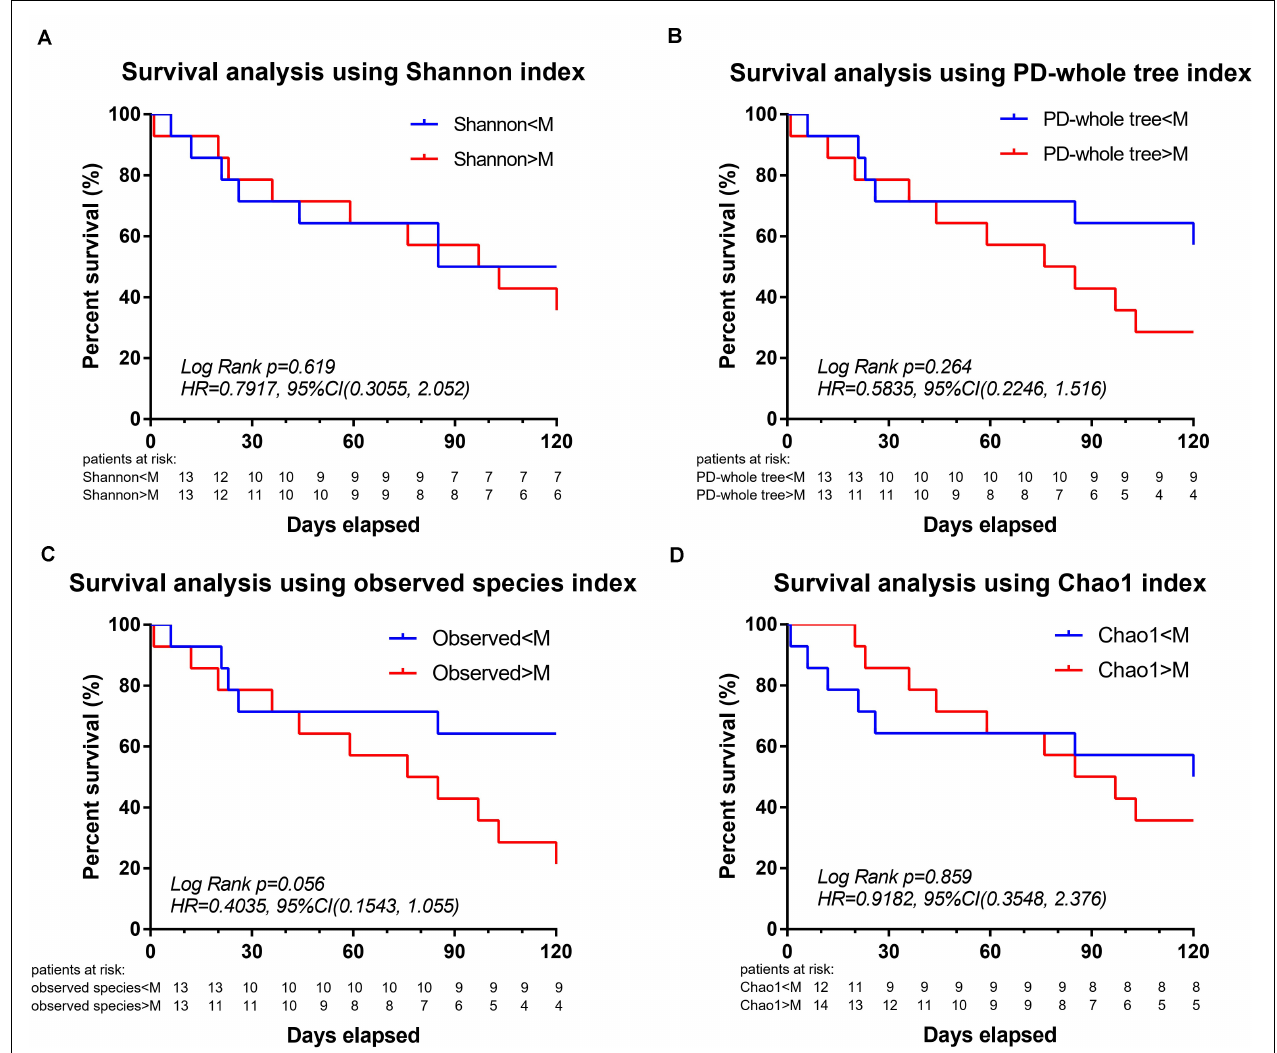
FIGURE 3 | Decreased intestinal microbiota diversity in encephalitis patients is not associated with survival in an exploratory setting. Based on the α -diversities in healthy subjects, the patient cohort was split into two groups: α -diversity < Median and α -diversity > Median, for which a 120-day Kaplan–Meier survival plot is shown. Twenty-eight encephalitis patients were divided based on the median of Shannon index [ A , Log Rank p = 0.619, HR = 0.7917, 95%CI = (0.3055, 2.052)], PD-whole tree index [ B , Log Rank p = 0.264, HR = 0.5835, 95%CI = (0.2246, 1.516)], observed species [ C , Log Rank p = 0.056, HR = 0.4035, 95%CI = (0.1543, 1.055)], Chao1 index ( D , Log Rank p = 0.859, HR = 0.9182, 95%CI = (0.3548, 2.376)], successively. M, median. Numbers below the curve were patients at risk per group.